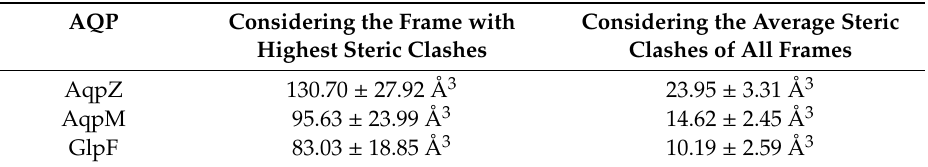
Table 2. Steric clashes for the three types of aquaporins (100 solutions were obtained for each one). Mean values for these 100 solutions and standard deviations are